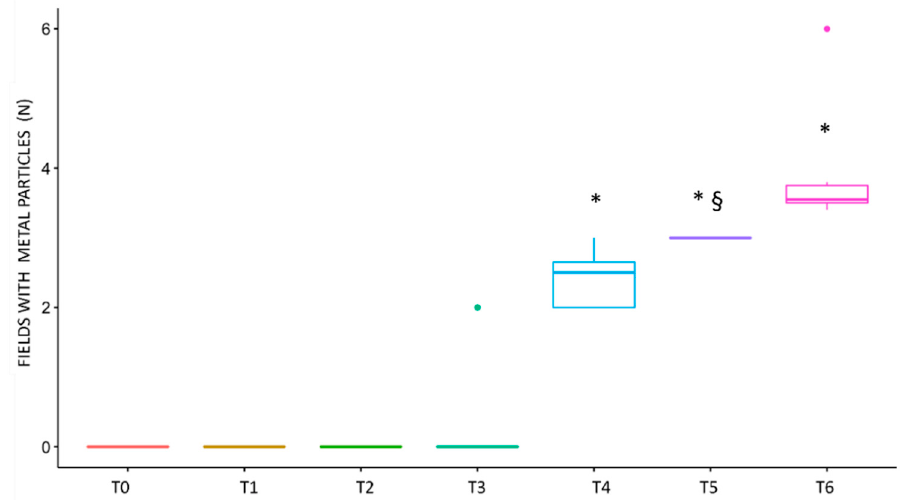
Figure 10. Graphical representation of the spotted fields with metal particles. The difference in the number of fields with metal debris was significant between T5 and T0, as revealed by the Wilcoxon test, indicated on the graph with §. The Bonferroni post-hoc analysis revealed a statistically significant difference in samples T4, T5, and T6 ( p value < 0.05), indicated on the graph with *.